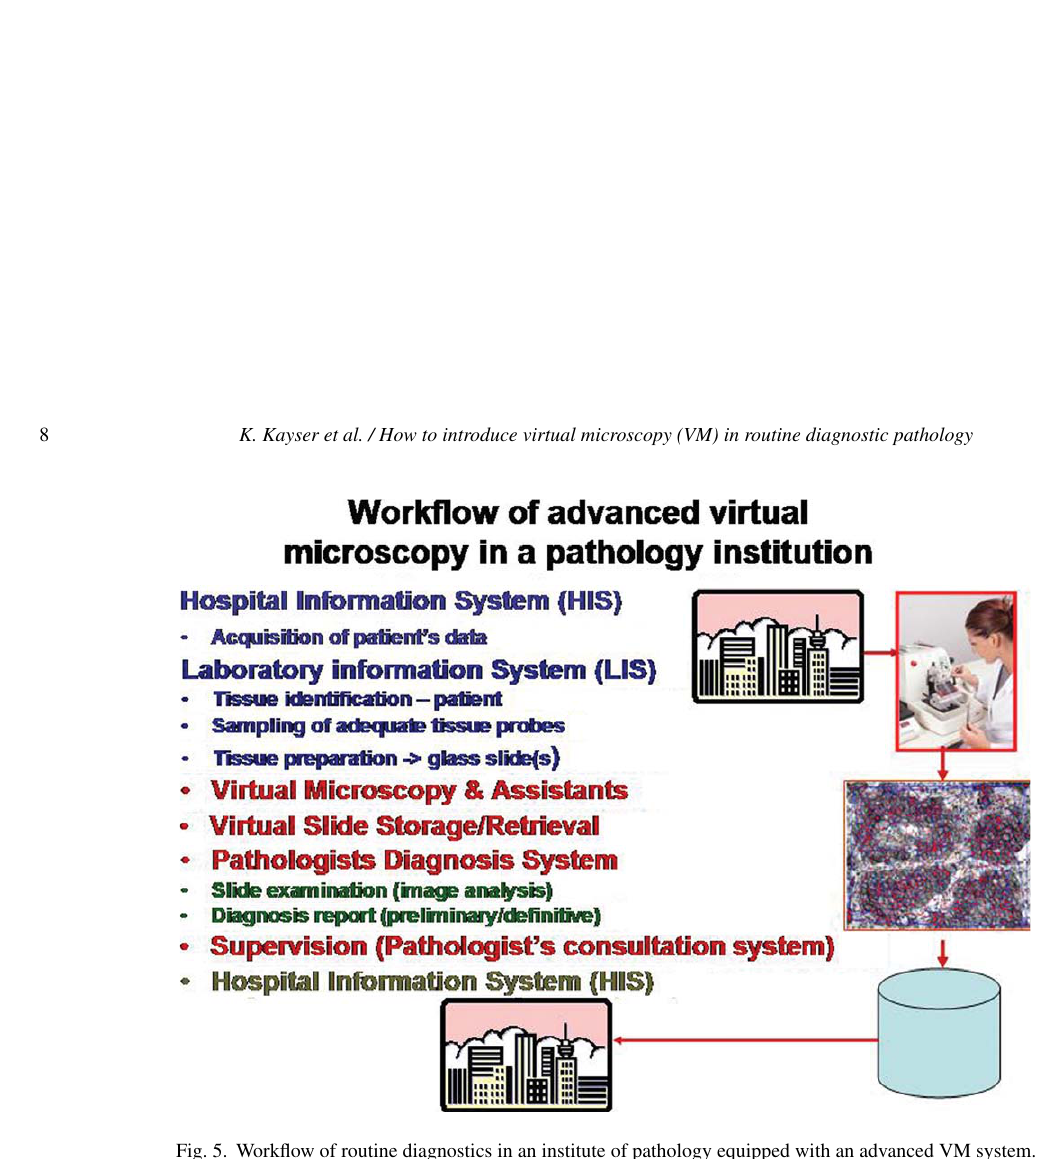
Fig. 5. Workflow of routine diagnostics in an institute of pathology equipped with an advanced VM system.